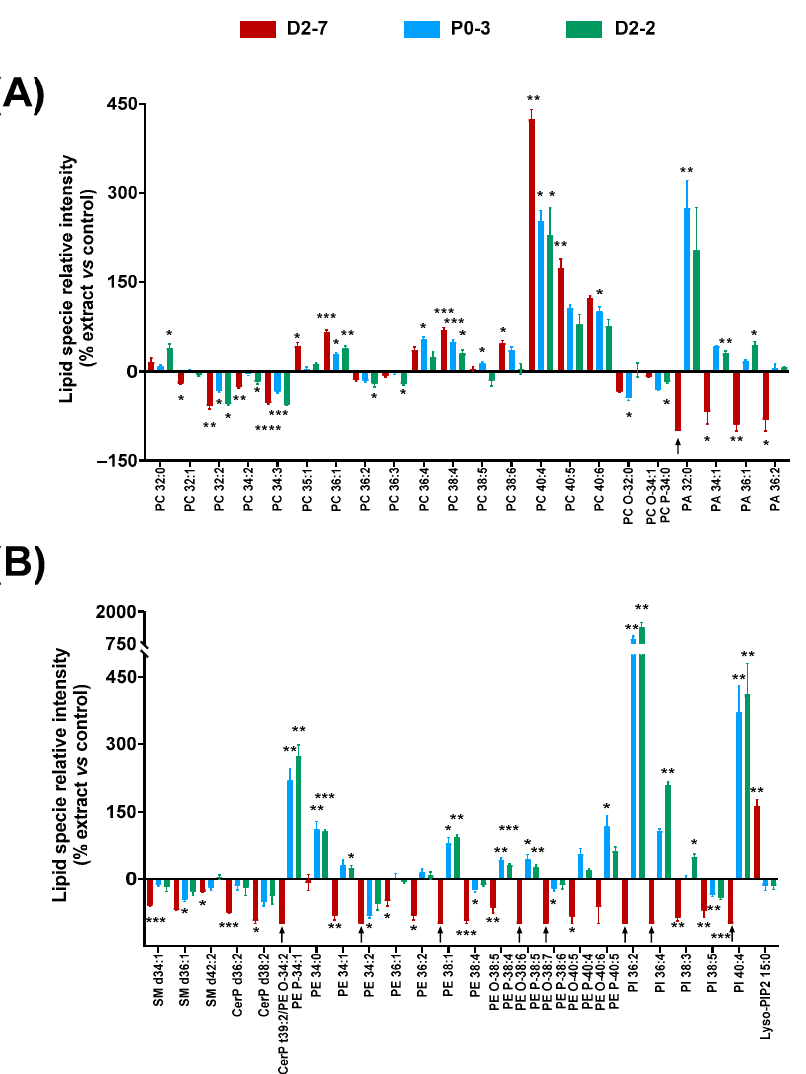
Figure 5. Changes in lipid fingerprint due to exposure to Cannabis sativa plant extracts, expressed as percentage of relative intensity of each extract with respect to the control. ( A ) Glycerophospholipids (PC, PC-O, PC-P, and PA). ( B ) Sphingolipids and glycerophospholipids (SM, CerP, PE, PE-O, PE-P, PI, and Lyso-PIP2). Normality was tested for each lipid species separately by Bartlett test; α was set at 0.05. Student t-test or Wilcoxon test were performed on the parametric or non-parametric samples, respectively. The tests were two-tailed; α was set at 0.05. p -value < 0.05 (*); <0.01 (**); <0.001 (***); and <0.0001 (****). Black arrows indicate the absence of a lipid species in this sample. Abbreviations: glycerophosphocholine, ether and plasmalogen forms—PC, PC-O, and PC-P); glycerophosphatidic acid—PA; sphingomyelin—SM; ceramide phosphate—CerP; glycerophosphoethanolamine, ether form and plasmalogen form—PE, PE-O, and PE-P; glycerophosphatidilinositol—PI; and lysophosphoinositol bisphosphate—Lyso-PIP2.